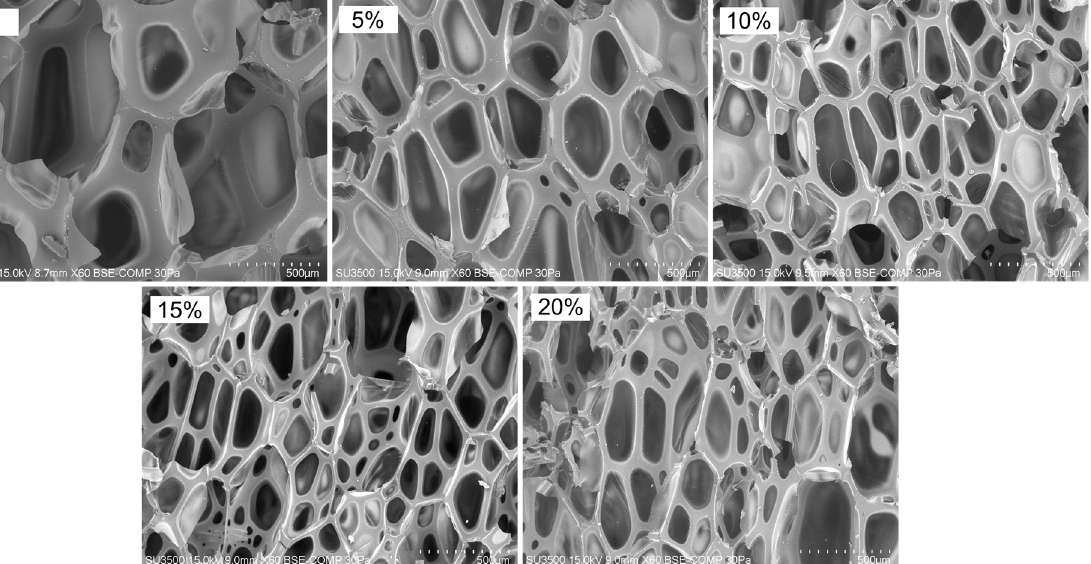
8 of 18 Figure 4. SEM images of PUR foam with addition of wood filler (arrows indicate changes in PUR